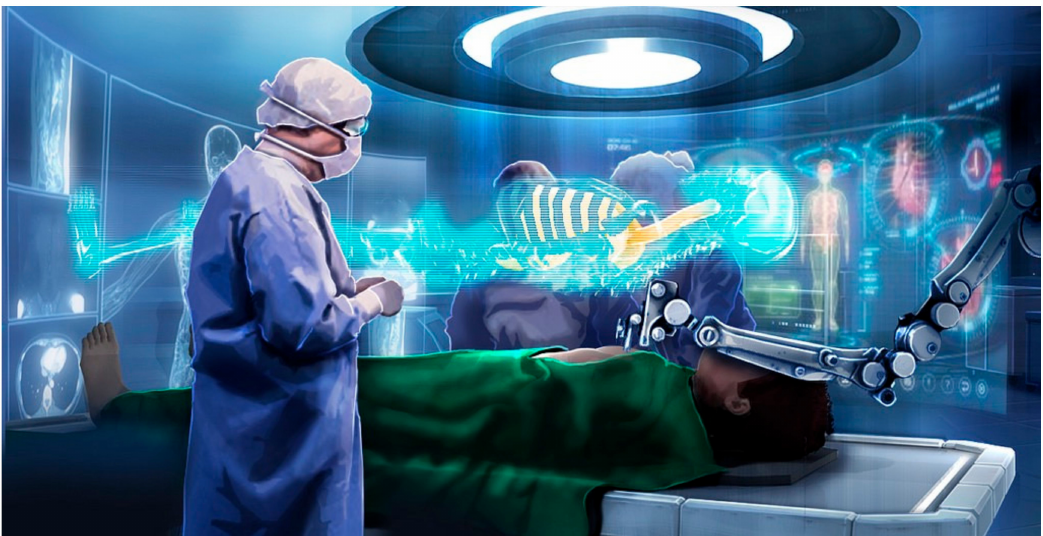
Figure 3. Replacement of a live patient by a virtual patient using MR. The risk to a live patient is reduced. The MR world, which is a simulation of the real world, can be enhanced using AI to meet the needs of the individual learner. Thus, specific learning outcomes for the adult learner can be more readily